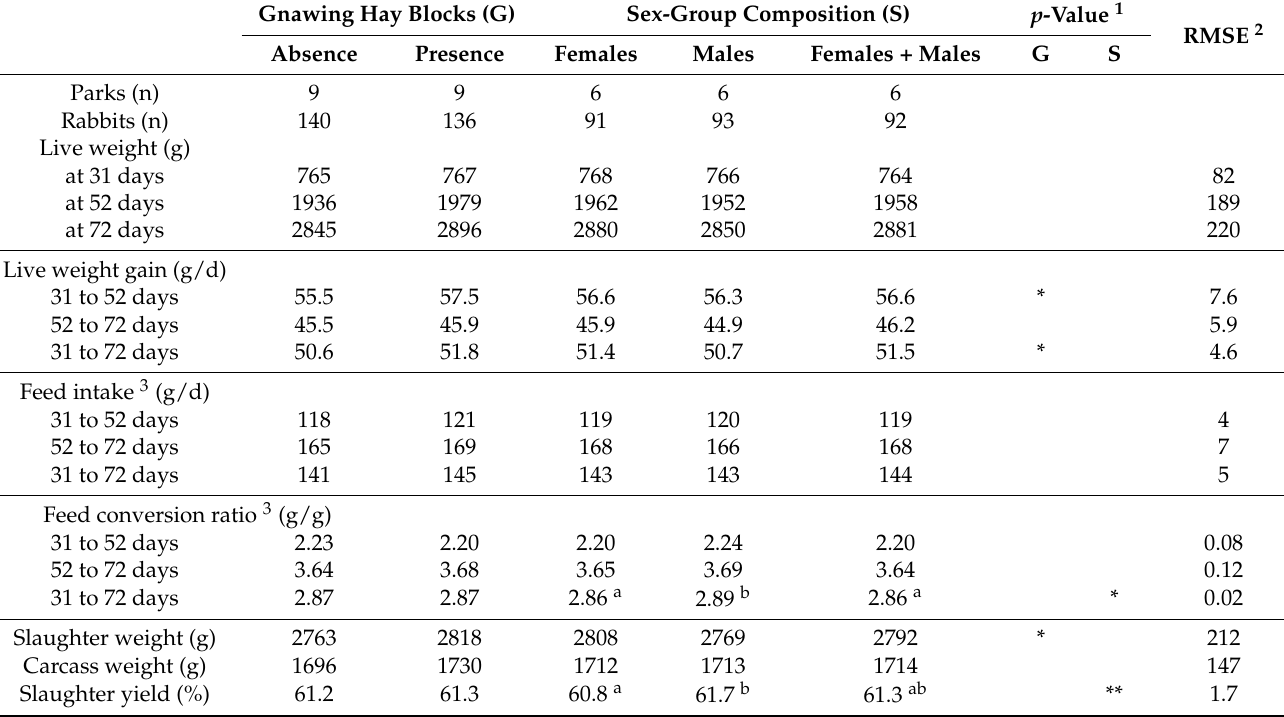
Table 1. Effect of the presence of gnawing hay blocks and sex-group composition in collective parks on performance (31 to 72 days of age) and slaughtering results (73 days of age) of growing rabbits. Gnawing Hay Blocks